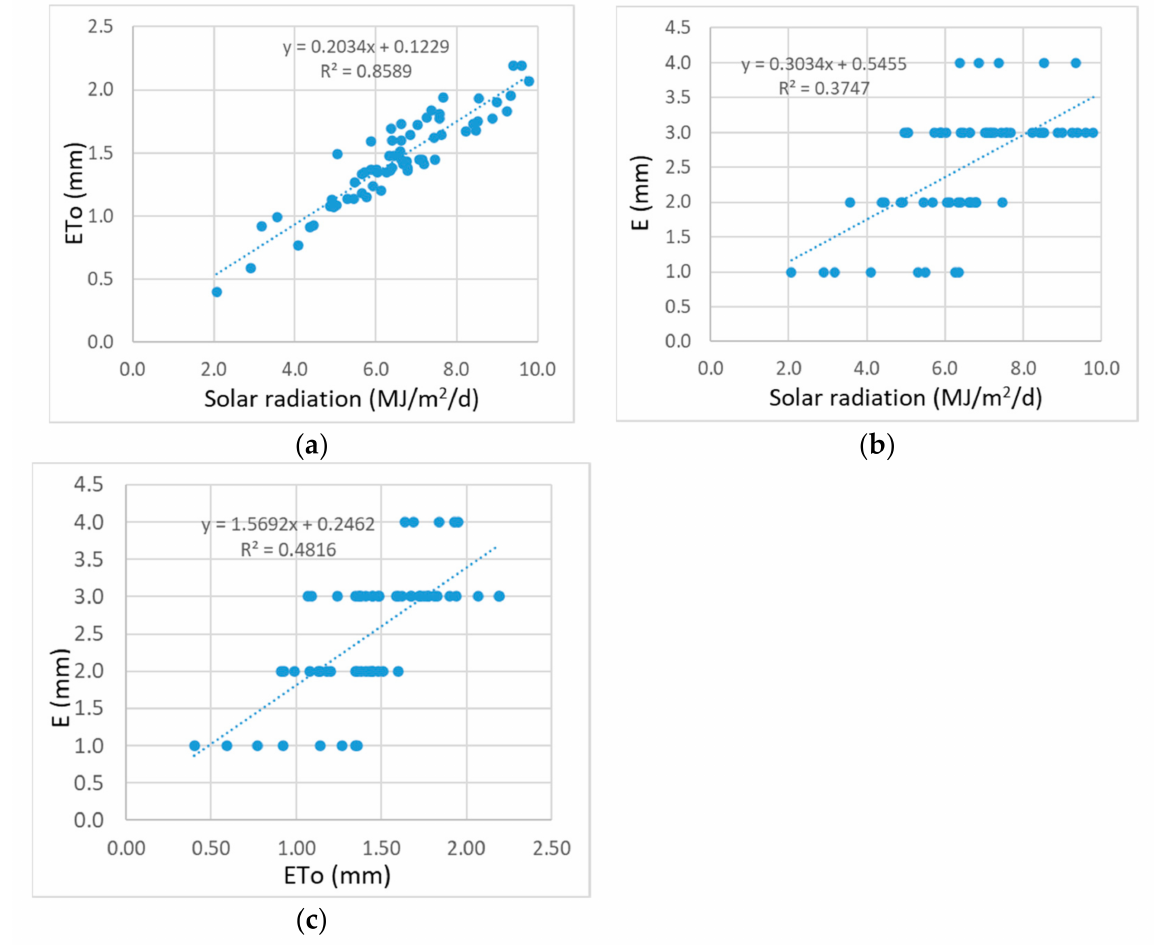
Figure 7. Relationship between ( a ) reference evapotranspiration (ETo) and solar radiation, ( b ) evapo- ration (E) and solar radiation, and ( c ) evaporation (E) and reference evapotranspiration